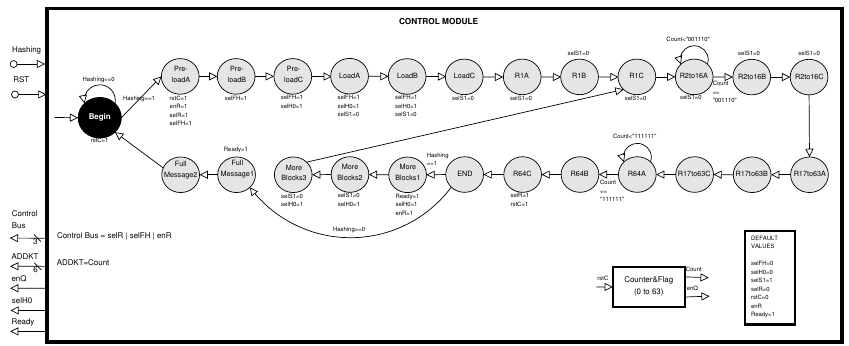
Figure 7. State diagram of the control